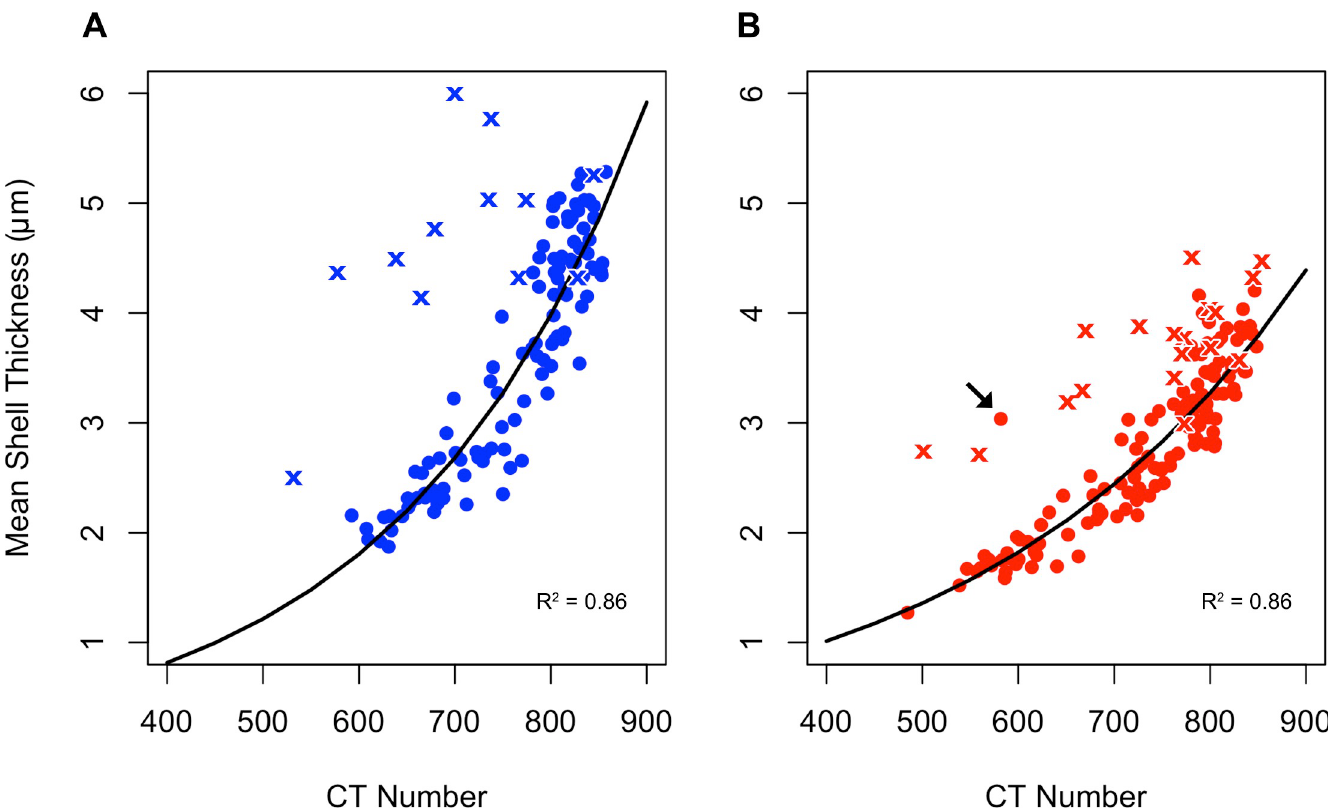
Fig 5. Shell thickness versus shell density. Mean shell thickness of A) Neogloboquadrina pachyderma and B) Turborotalita quinqueloba plotted versus mean shell density in the form of a CT number, fitted with an exponential model. Shells from water column samples are represented by circles, while crosses represent shells from surface sediments. Exponential model is only fitted to shells from water column. Arrow in B) is pointing to an outlier.